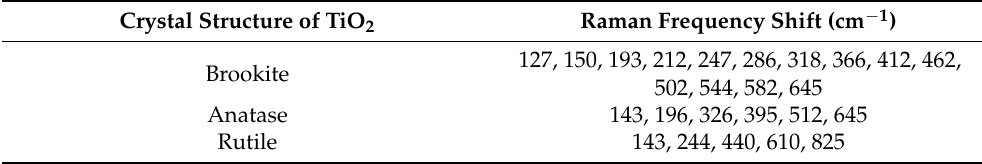
Table 1. Raman spectra characteristic frequency shift position of three crystalline TiO 2 .